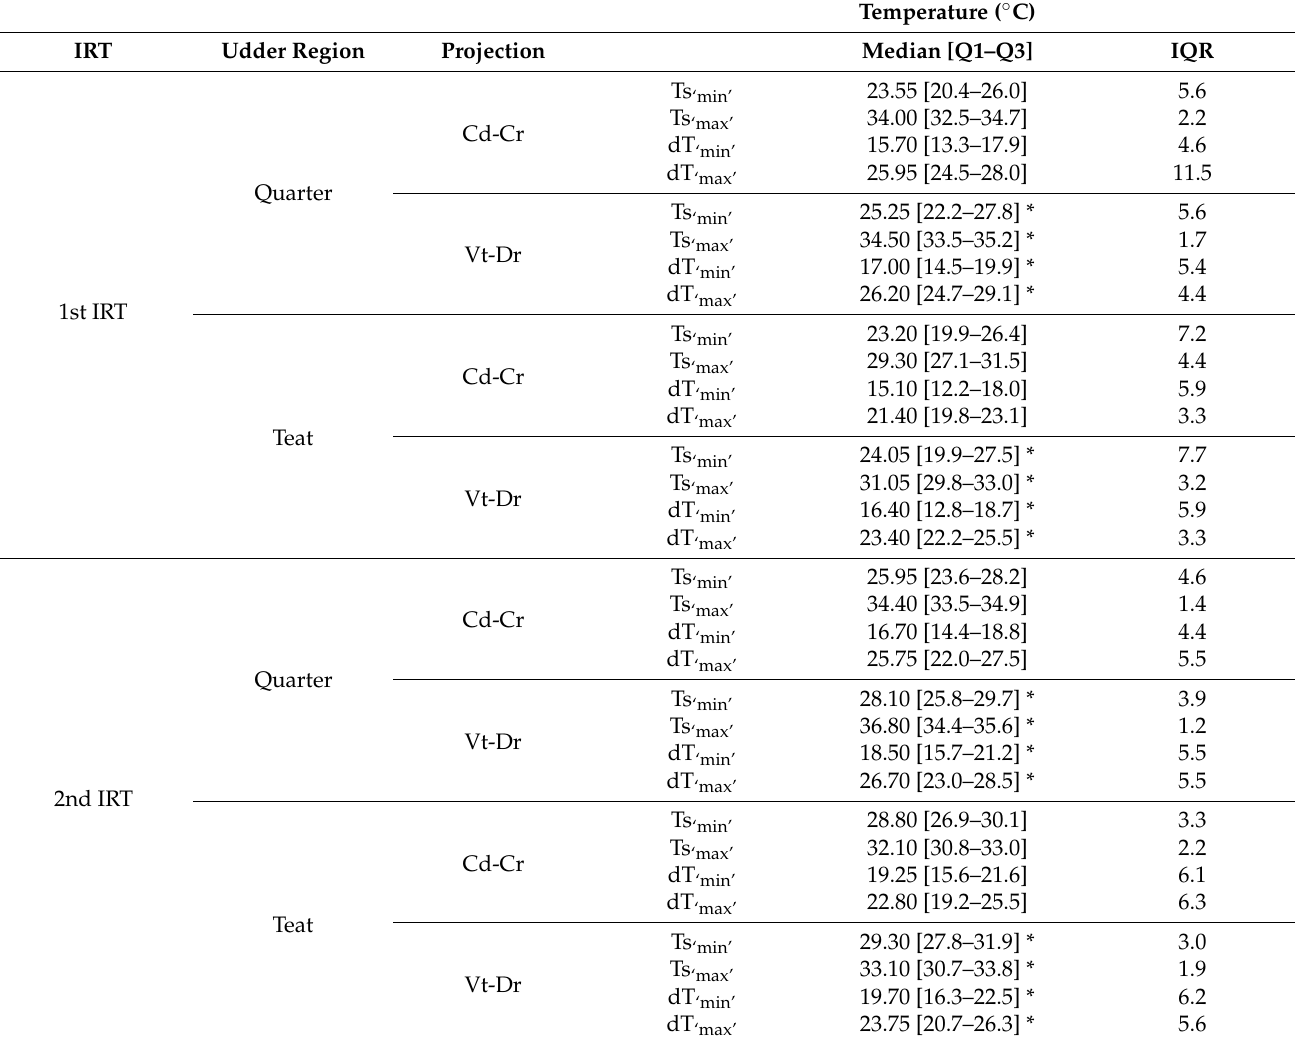
Table 1. Descriptive results of surface temperature (Ts) and temperature gradient (dT) at first ( n = 119 heifers) and second IRT ( n = 116